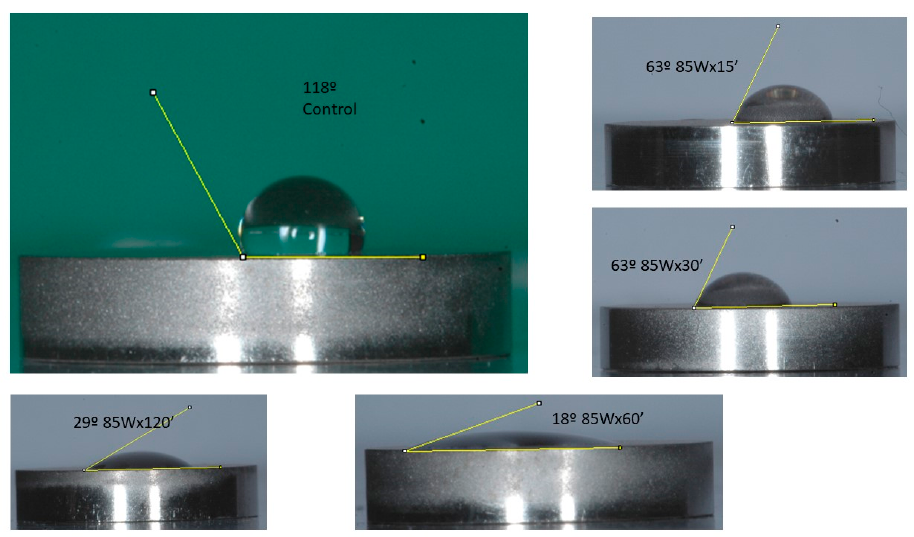
Figure 5. Composition of the different angles obtained with irradiation at 85 W for different time intervals compared with the control.